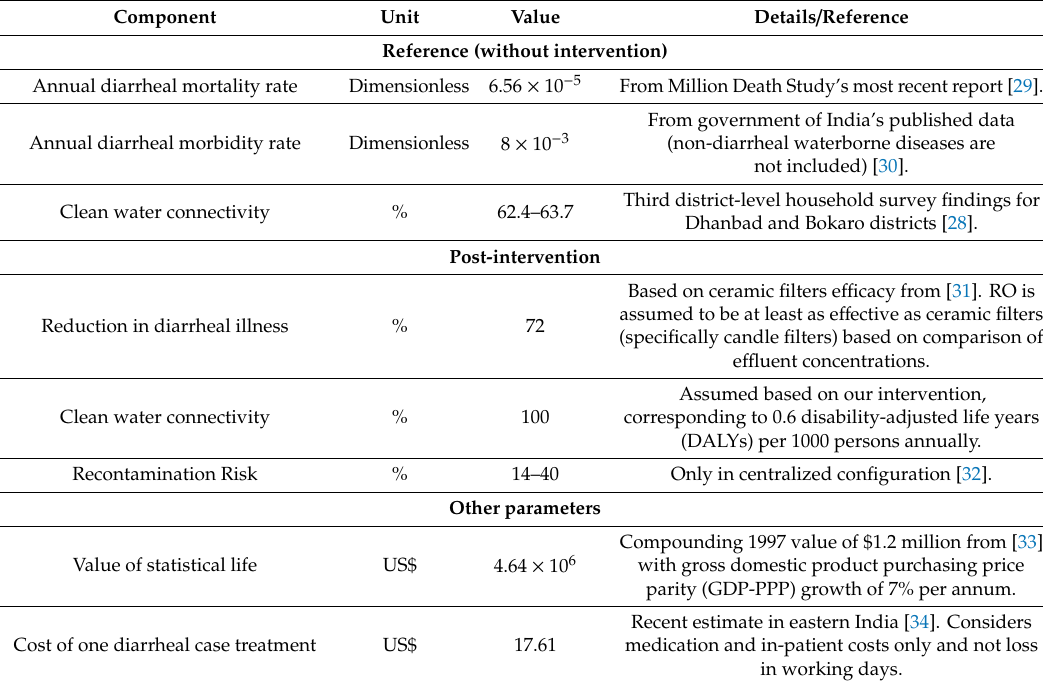
Table 2. Important parameters for estimating